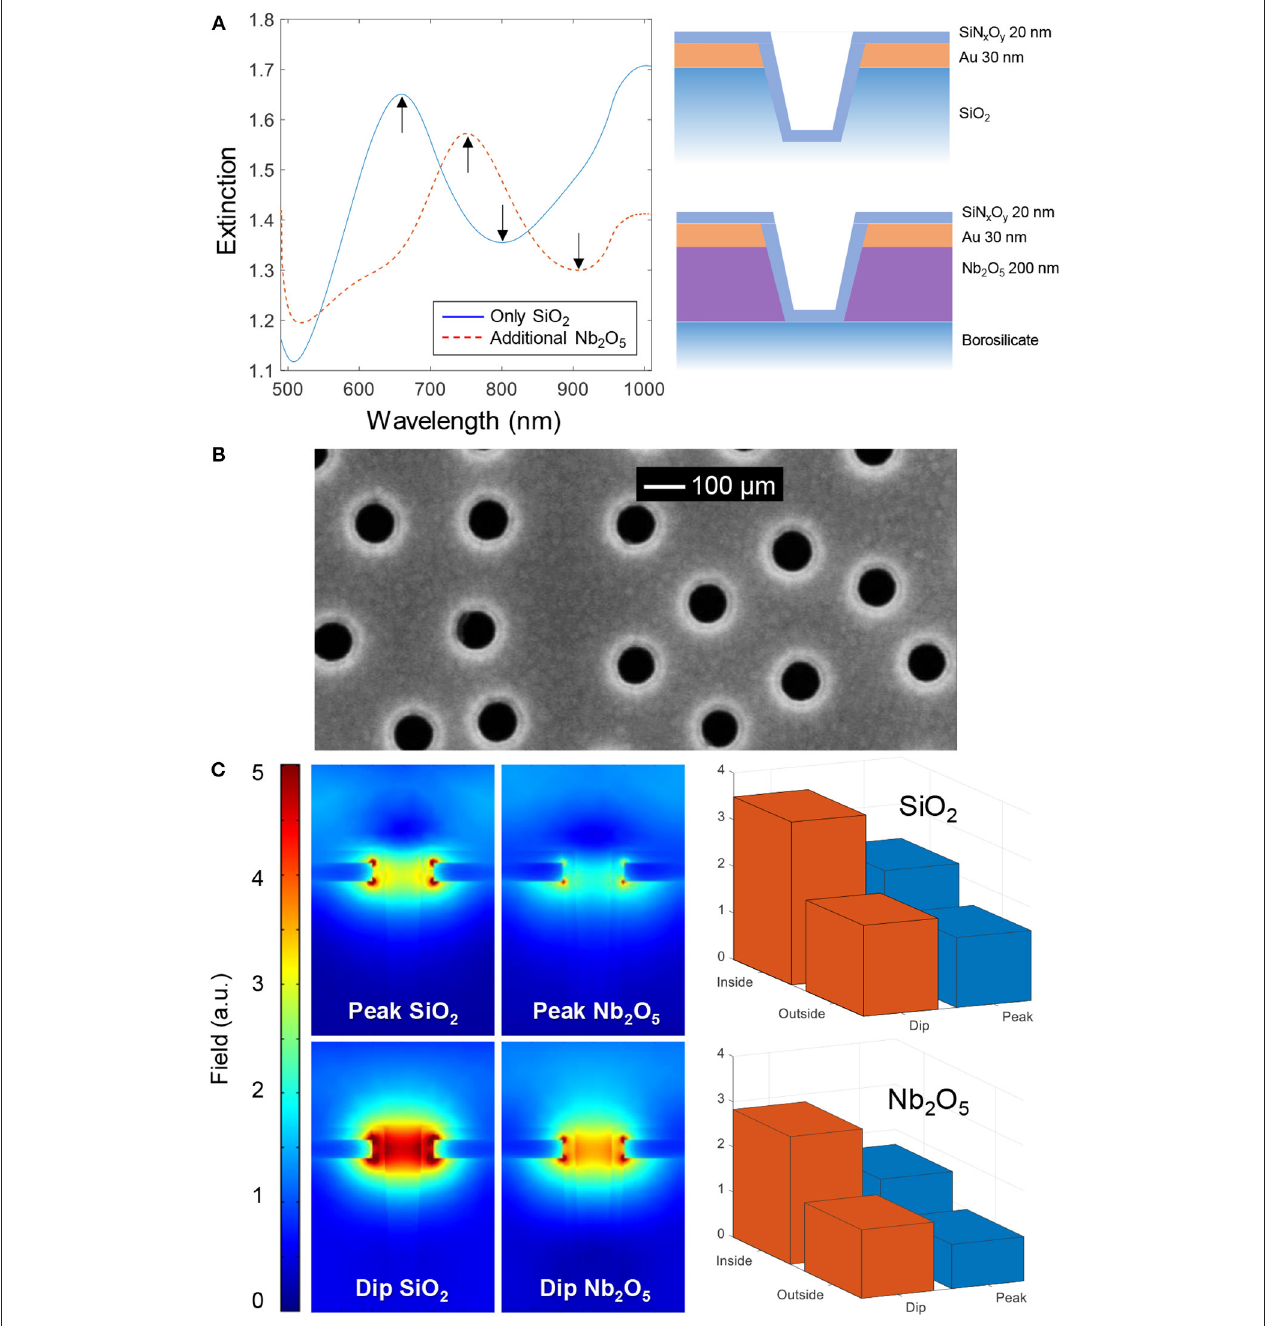
FIGURE 2 | The two types of nanowells. (A) Extinction spectra in water and nanostructure schematics. (B) Electron microscopy image of nanowells in SiO 2 coated with SiN x O y . (C) Simulated near fields at the peak and dip wavelengths for square arrays with periodicity of 300nm in water. The bar plots show the average field strength on the planar surface (outside) vs. the curved surface exposed inside the nanowells (inside), in both cases 5nm away from the SiN x O y coating (which has refractive index